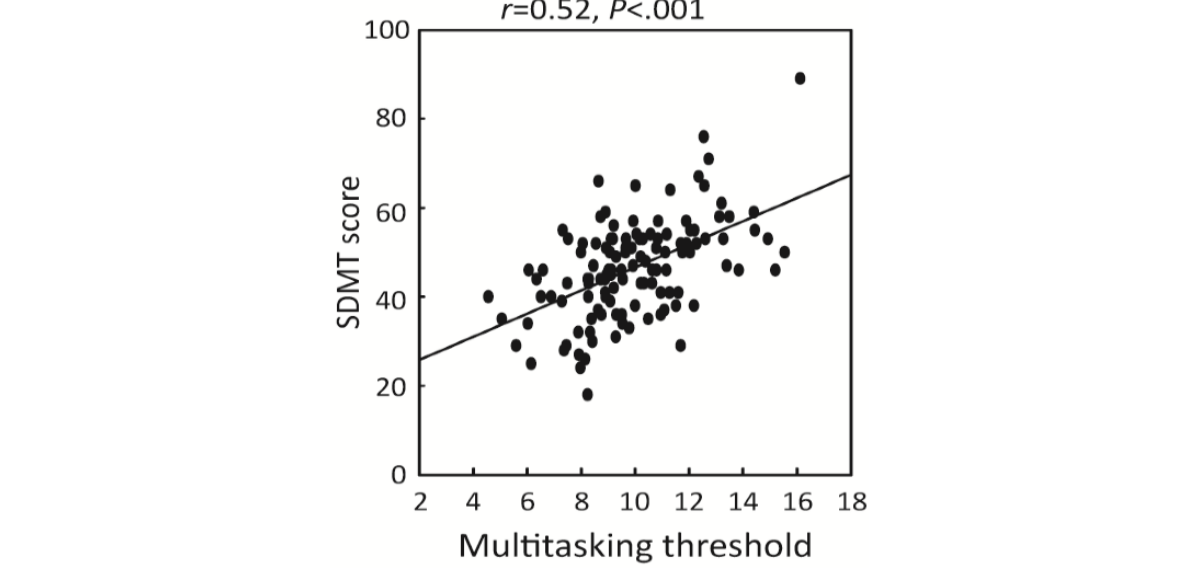
Figure 4. Correlation between EVO Monitor performance and SDMT score. SDMT: Symbol Digit Modalities